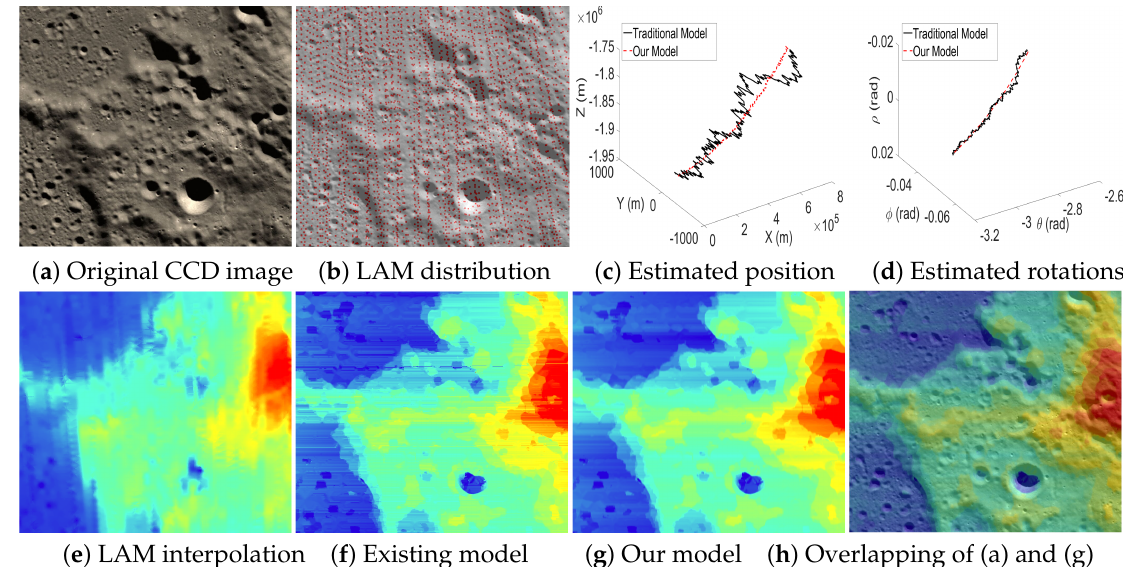
Figure 12. Case 2 with a dense LAM